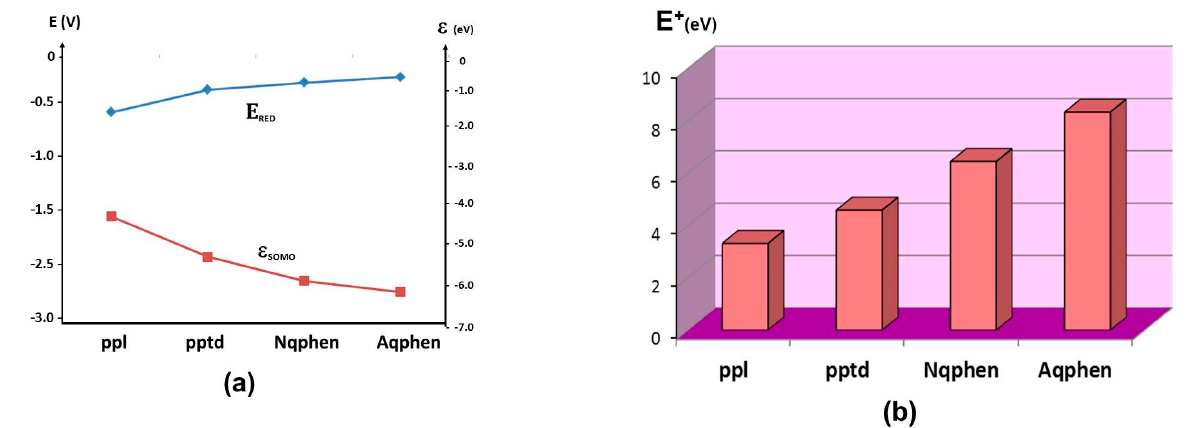
Figure 3. ( a ) Values for the reduction potentials of the ligands, and for the calculated energy of the SOMO. ( b ) Electrophilicity Index. SOMO. ( b ) Electrophilicity